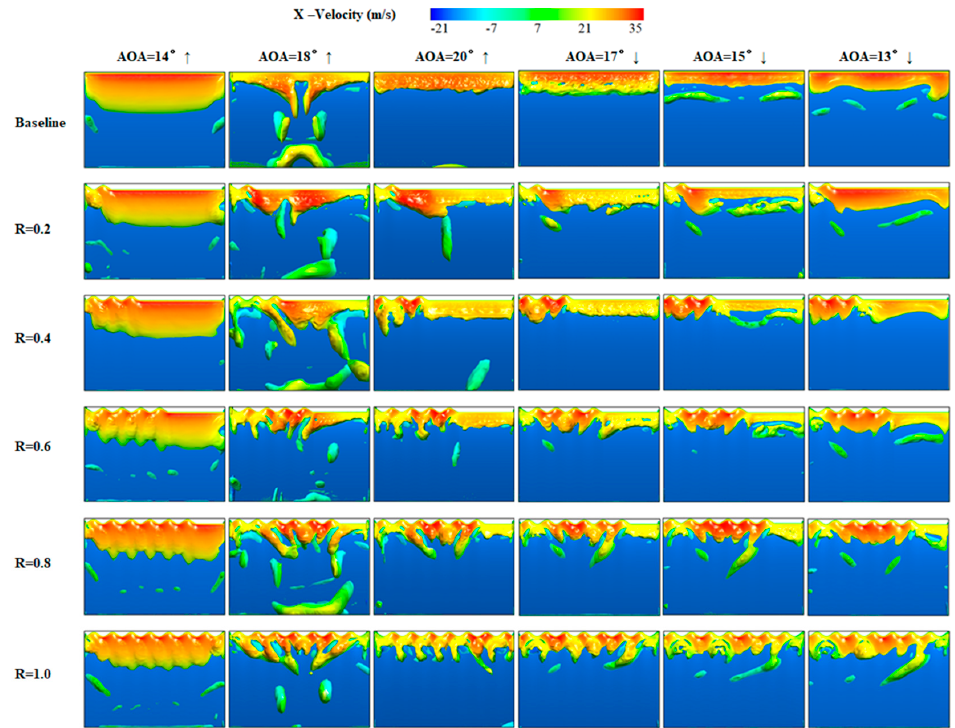
Figure 11. Iso-surfaces of vorticity (Q = 200,000 s − 2 ) with velocity for different airfoils. As shown in Figure 11, the airflow on the surface of the baseline airfoil had an asym- metrical distribution at various angles of attack. When a bionic wavy leading edge was added, the vortex structure on the airfoil surface changed significantly; for instance, using an 18° angle of attack as an example, when R = 0.2 and 0.4, the symmetrical distribution of the vortex structure on the airfoil surface is broken. However, the vortex size and strength do not decrease significantly in these cases. When R = 0.6, 0.8, and 1.0, it reduces the size and strength of the airfoil surface vortex structure and suppresses the dynamic stall effect. 4.4. Lift and Drag Coefficients of Different Airfoils Figure 12 shows the lift and drag characteristic curves of airfoils with different values of R, as well as the baseline airfoil in dynamic stall for a Reynolds number of 3 × 10 5 . When R = 0.2, the peak lift coefficient of the bionic airfoil was almost the same as that of the baseline airfoil. When R = 0.4, the peak lift coefficient of the bionic airfoil decreased slightly. With increasing R, the bionic wavy leading edge gradually weakened the hyste- resis effect of the airfoil lift coefficient. When R = 0.6, 0.8, and 1.0, the bionic leading edge reduced the peak value of the lift coefficient and reduced the delay in the flow reattachment. The peak value of the drag coefficient during pitch-up was significantly reduced for all the bionic airfoils compared with the baseline airfoil, whereas the drag coefficient of each bionic airfoil was the same as that of the baseline airfoil during pitch-down.